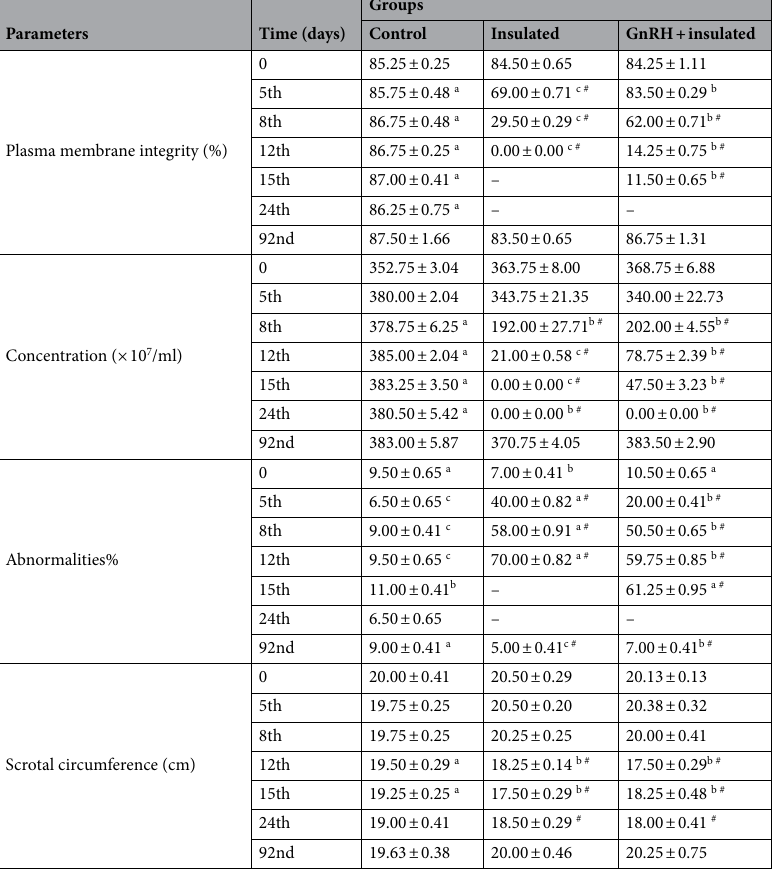
(Fig. 1A), whereas those in the INS group had large amounts of lipids (Fig. 1B). The cytoplasm of the Sertoli cells and primary spermatocytes was filled with vacuoles and did not maintain cellular contact with spermatocytes and spermatids in the INS group compared with those in the CON and GnRH + INS groups (Fig. 1B). For the GnRH + INS group, the Sertoli cells showed a larger cytoplasmic process with minimal lipid inclusions (Fig. 1C). Immunohistochemistry expression of active caspase 3 and VEGF. The expression of active caspases-3 immu- nostaining was observed in Sertoli, germ, and Leydig cells. As expected, caspase-3 expression was weak in the CON group (Fig. 2A,B). The expression of caspase-3 in Sertoli, germ, and Leydig cells in the GnRH + INS group (Fig. 2E,F) was lower than that in the INS group (Fig. 2C,D). A negative image obtained using the CMEIAS color segmentation technique showed the reaction in different types of cells (Supplementary Fig. 1). Active caspase expression was evaluated by counting the number of caspase-immunoreactive cells in all experimental groups (Fig. 3). The highest number of active caspase-3 was observed in Sertoli (Fig. 3A), germ (Fig. 3B), and Leydig cells (Fig. 3C) in the INS group compared with that in the GnRH + INS group. The lowest number was detected in the CON group. The expression of VEGF immunoreactivity staining was weak in Sertoli, germ, and Leydig cells and in the vascular endothelium of blood vessels (Fig. 4A–C) in the CON group. In the INS group, the reaction was relatively stronger in all cell types compared with that in other groups (Fig. 4D–I). The expression was weak in Sertoli and germ cells and moderate in Leydig cells in the GnRH + INS group compared with that in the INS group and nearly similar to that in the CON group (Fig. 4J–L). A negative image is represented as Supplementary Fig. 2. Regarding the reciprocal intensity of VEGF, the highest intensity of VEGF was observed in Sertoli (Fig. 5A), germ (Fig. 5B), and Leydig (Fig. 5C) cells and vascular endothelium (Fig. 5D) in the INS groups compared with that in the GnRH + INS group. The lowest intensity of VEGF was detected in the CON group. Supplemen- tary Figs. 3 and 4 represent the negative and positive control immunostaining of active caspase-3 and VEGF, respectively.